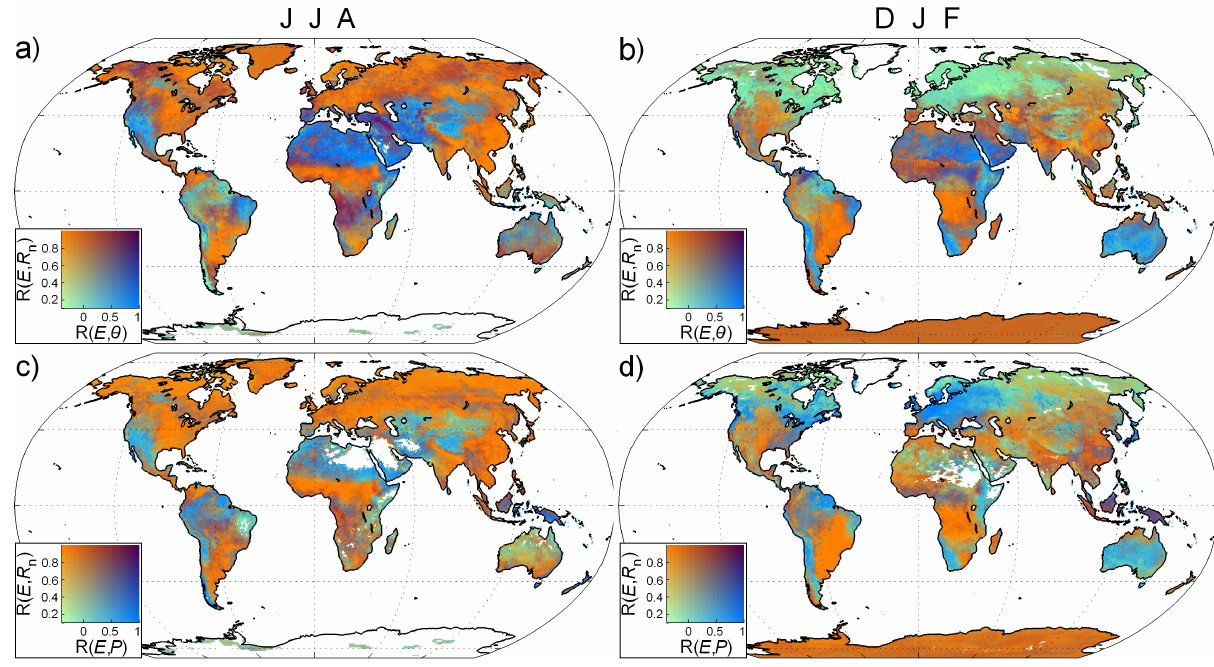
Fig. 8. The upper panel shows the estimated correlation ( R ) of daily time series of E with R n and θ for (a) JJA and (b) DJF. The bottom figures show the correlation of daily E with R n and P during (c) JJA and (d) DJF. All the results correspond to the period 2003–2007.